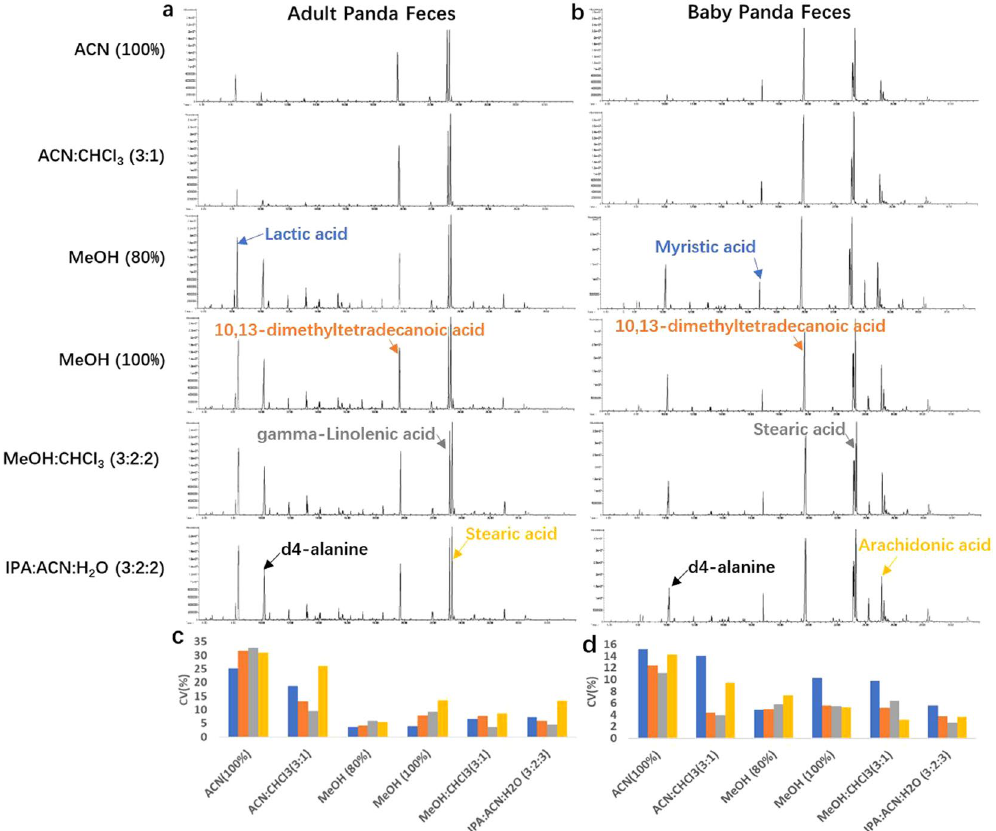
Figure 2. Representative total ion chromatograms (TIC) of the fecal metabolome for adult ( a ) and baby ( b ) giant pandas, using six different exaction solvents. The coefficient of variation (CV) of four highly abundant chromatographic peaks were calculated for adult ( c : lactic acid, 10,13-dimethyltetradecanoic acid, gamma- linolenic acid, stearic acid) and baby giant pandas ( d : myristic acid, 10,13-dimethyltetradecanoic acid, stearic acid, arachidonic acid). ACN (100%); acetonitrile: chloroform in 3:1 ratio (ACN:CHCl 3 (3:1)); 80% methanol (MeOH (80%)); 100% methanol (MeOH (100%)); methanol: chloroform in 3:1 ratio (MeOH:CHCl 3 (3:1)); isopropanol: acetonitrile: water in 3:2:2 ratio (APN:ACN:H 2 O